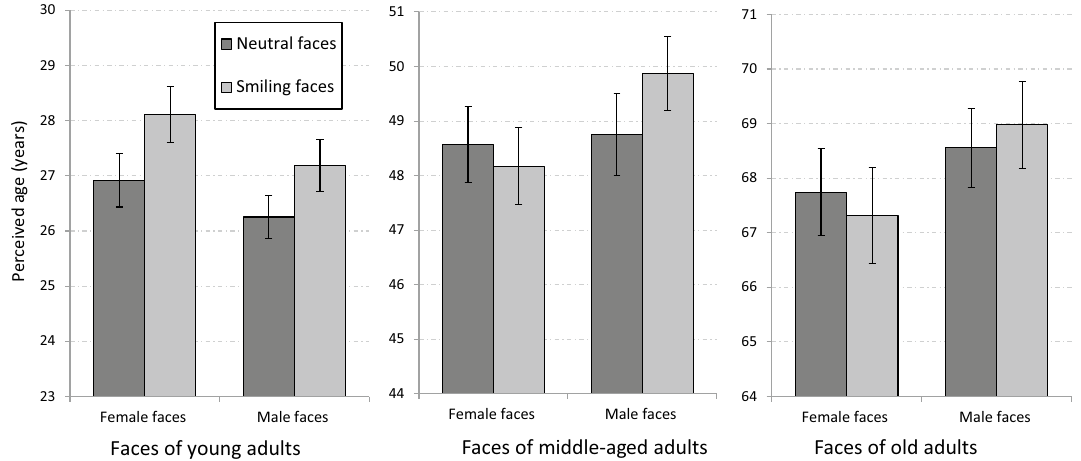
Figure 2. The aging effect of smiling (AES) in different age groups of faces in Experiment 1a (full faces). AES was found for male and for female faces in young adults, but only for male faces in middle-aged adults. No AES was found for faces of old adults. Error bars represent standard errors of the mean.